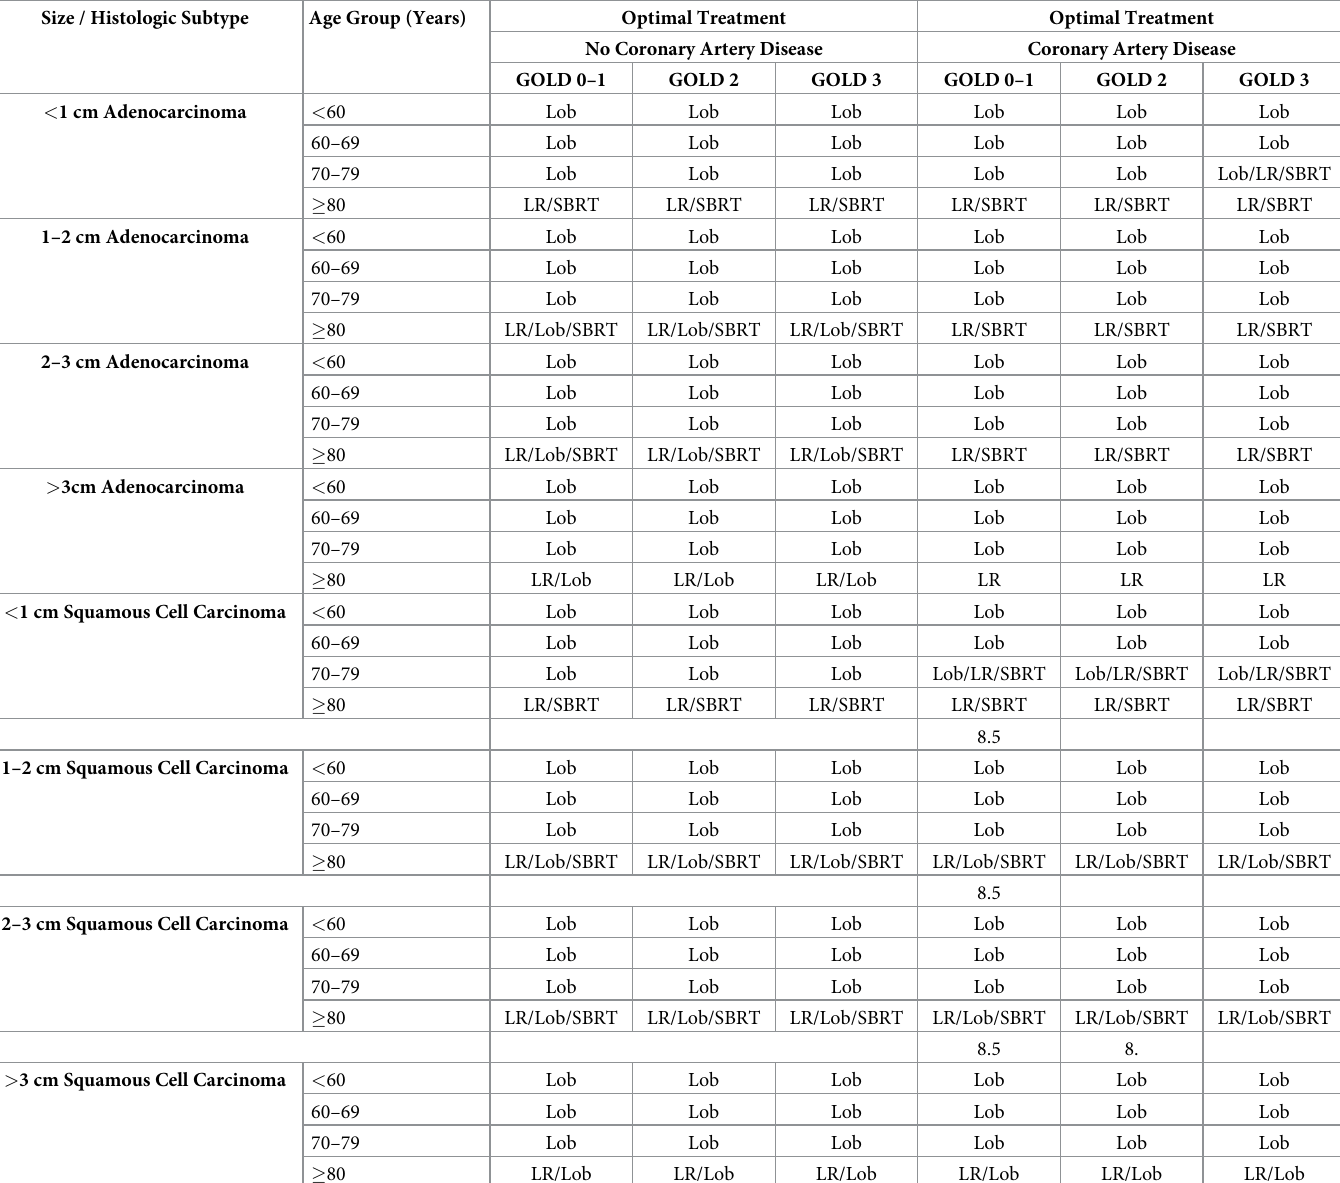
Table 2. Non-small cell lung cancer stage I treatments that maximize quality-adjusted life year gains by comorbidity status �